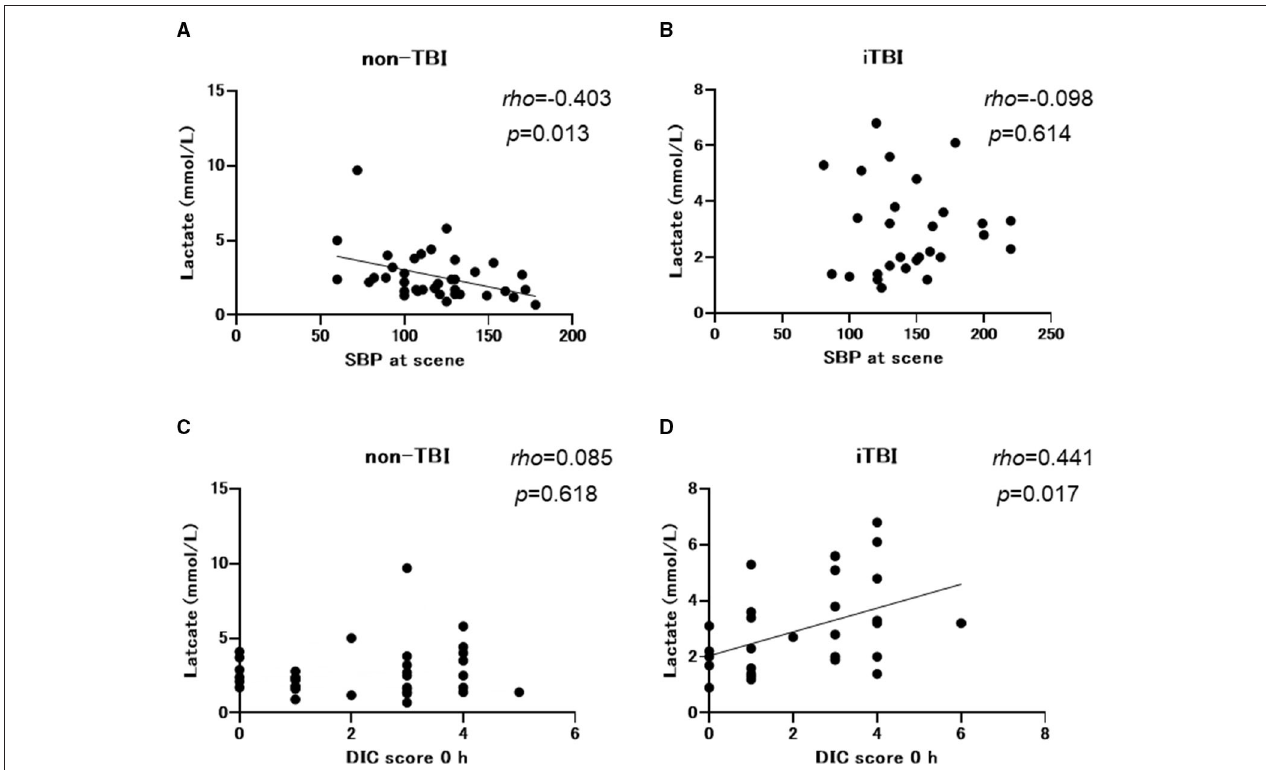
FIGURE 3 | Spearman’s rank correlation coefficients between the lactate levels and systolic blood pressure (SBP) at scene and the disseminated intravascular coagulation (DIC) score at arrival to the emergency department. TBI, traumatic brain injury; iTBI, isolated traumatic brain injury.